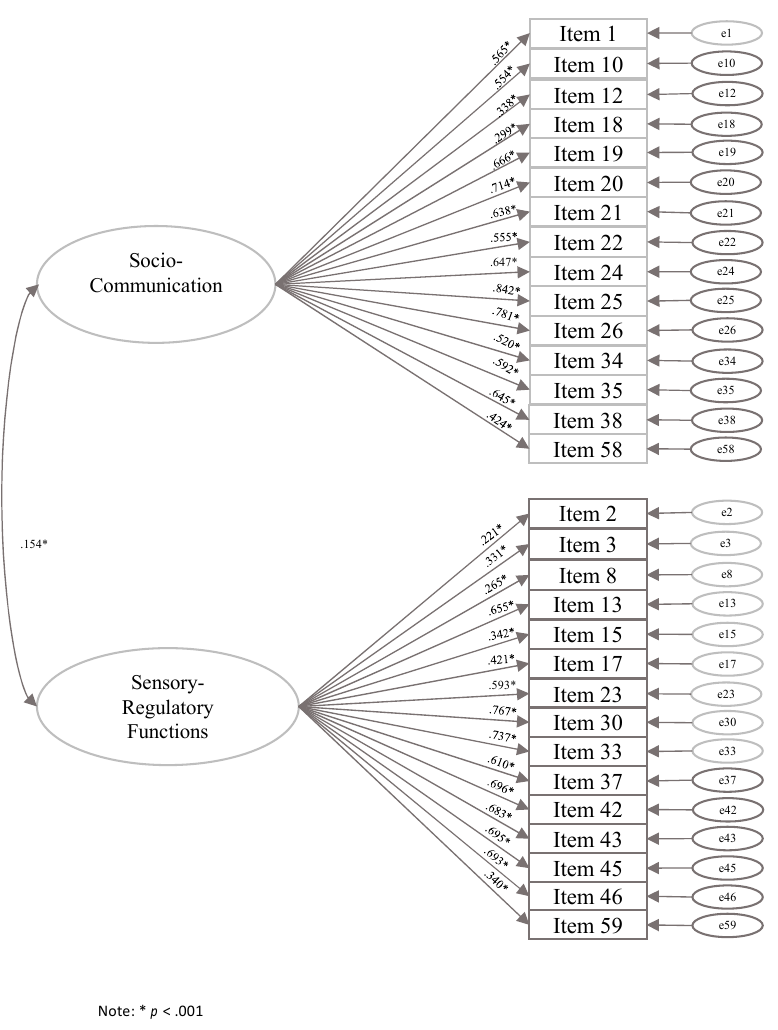
Figure 4. FYI Structure according to Confirmatory Factor Analysis (CFA) run in this study.